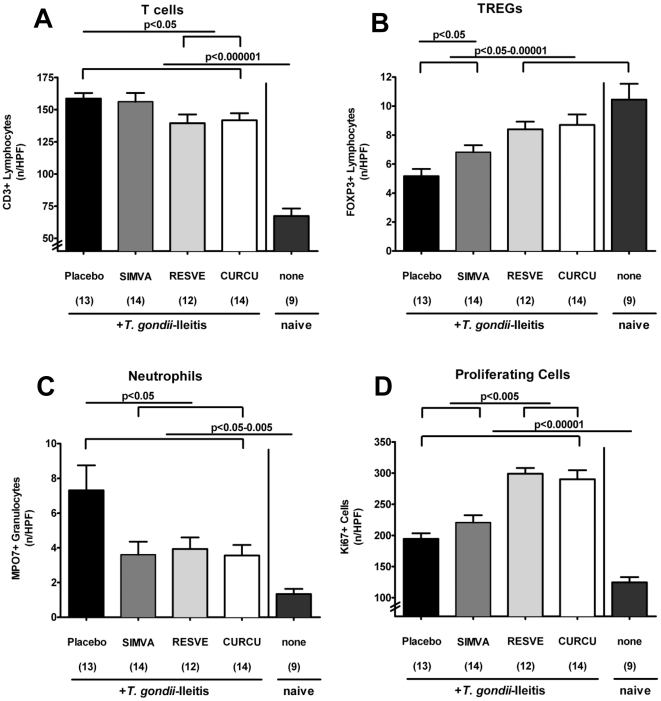
Quantification of defined cell population in the ileum of mice in situ after treatment with Simvastain, Resveratrol or Curcumin (8 days after T. gondii infection).The average number of cells positive for (A) CD3, (B) FOXP3, (C) MPO7 (Myeloperoxidase), and (D) Ki-67 from at least six high power fields (HPF, 400× magnification) per animal were determined microscopically in immunostained ileum sections at d8 p.i. after treatment of mice with Placebo, Simvastain (SIMVA), Resveratrol (RESVE), or Curcumin (CURCU) from d-2 until d8 p.i. and naïve, uninfected animals. Numbers of analyzed animals are given in parentheses. Mean values, standard errors of the mean, and significance levels as indicated were determined by the Student's t test. Data are pooled from at least three independent experiments.